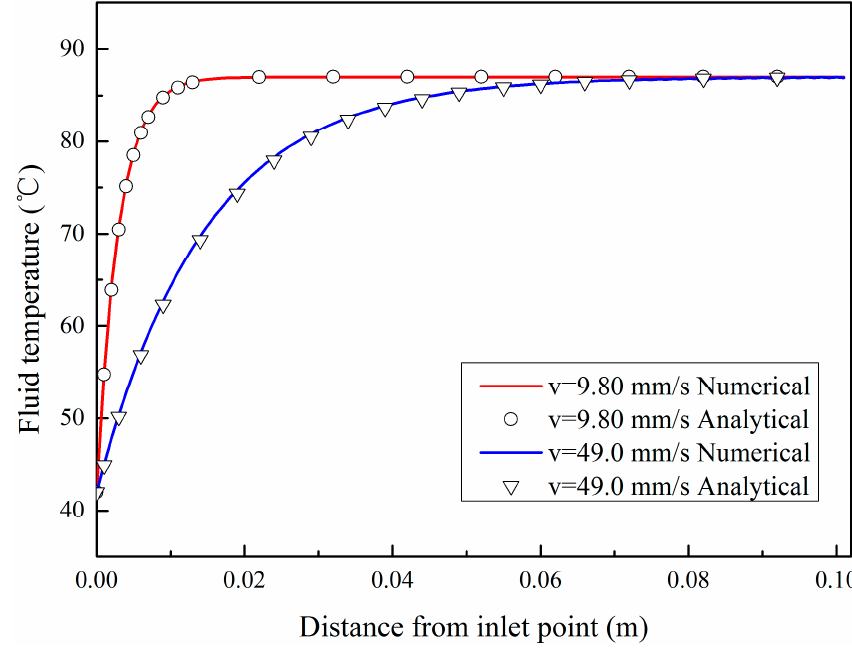
Figure 2. The fluid temperature in the fracture.